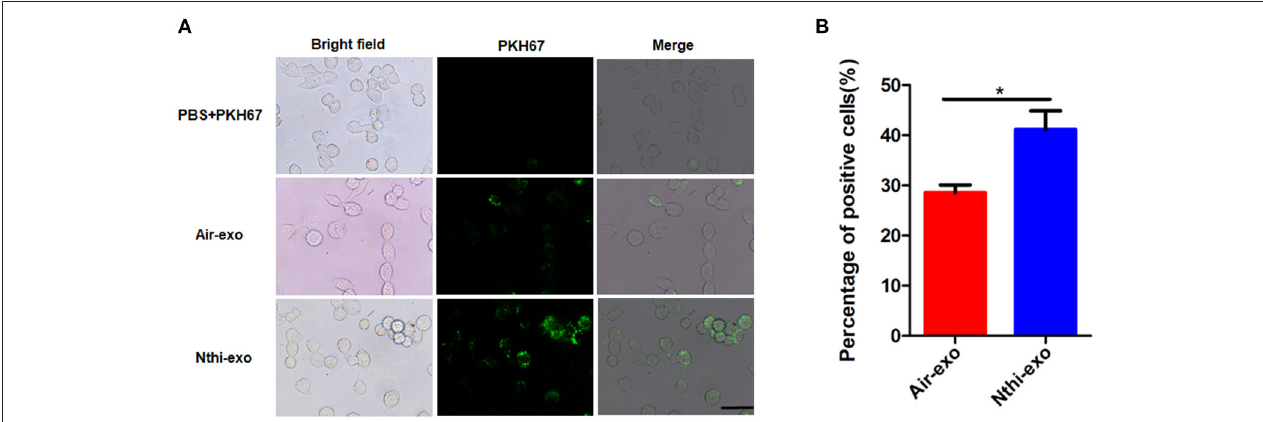
FIGURE 5 | Internalization of exosomes from the BALF of mice exposed to NTHi lysate or air. (A) LLC cells demonstrated uptake of labeled-exosomes (green fluorescent dye), images are taken at 24h co-culture with LC cells. Scar bar = 100 µ m. (B) the percentage of positive LLC cells engulfing labeled-exosomes ( n = 10). Results are presented as means ± SEM. (* P < 0.05).